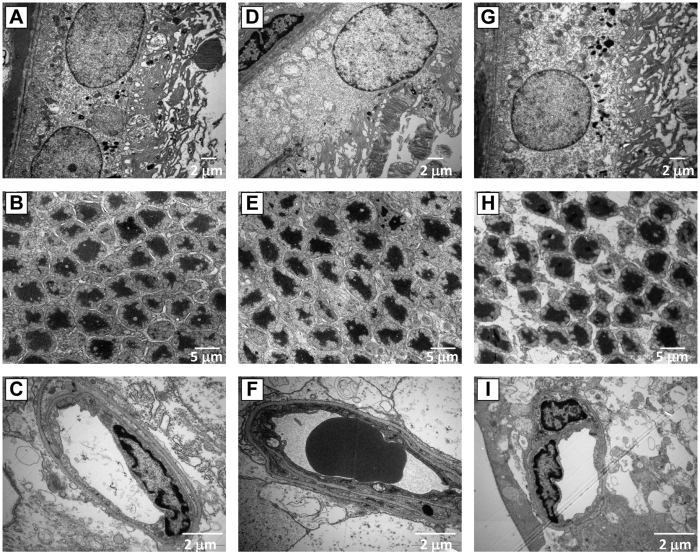
TEM analysis of the retina.Retinal morphology in Group N (A–C), Group A (D–F) and Group L (G–I). Disorganization of the villous structure of pigmented cytoplasm, cytoplasmic vacuolation and deterioration of cytoplasmic organelles were observed in rats treated with AT1-AA as compared with normal rats (D). Chromatin aggregation, and condensation, deformation and dissolution of photoreceptor cells were observed (E). The capillary lumen was narrow and capillary endothelial cells contained vacuoles (F). After treatment with losartan, retinal layers of the structure has improved significantly.